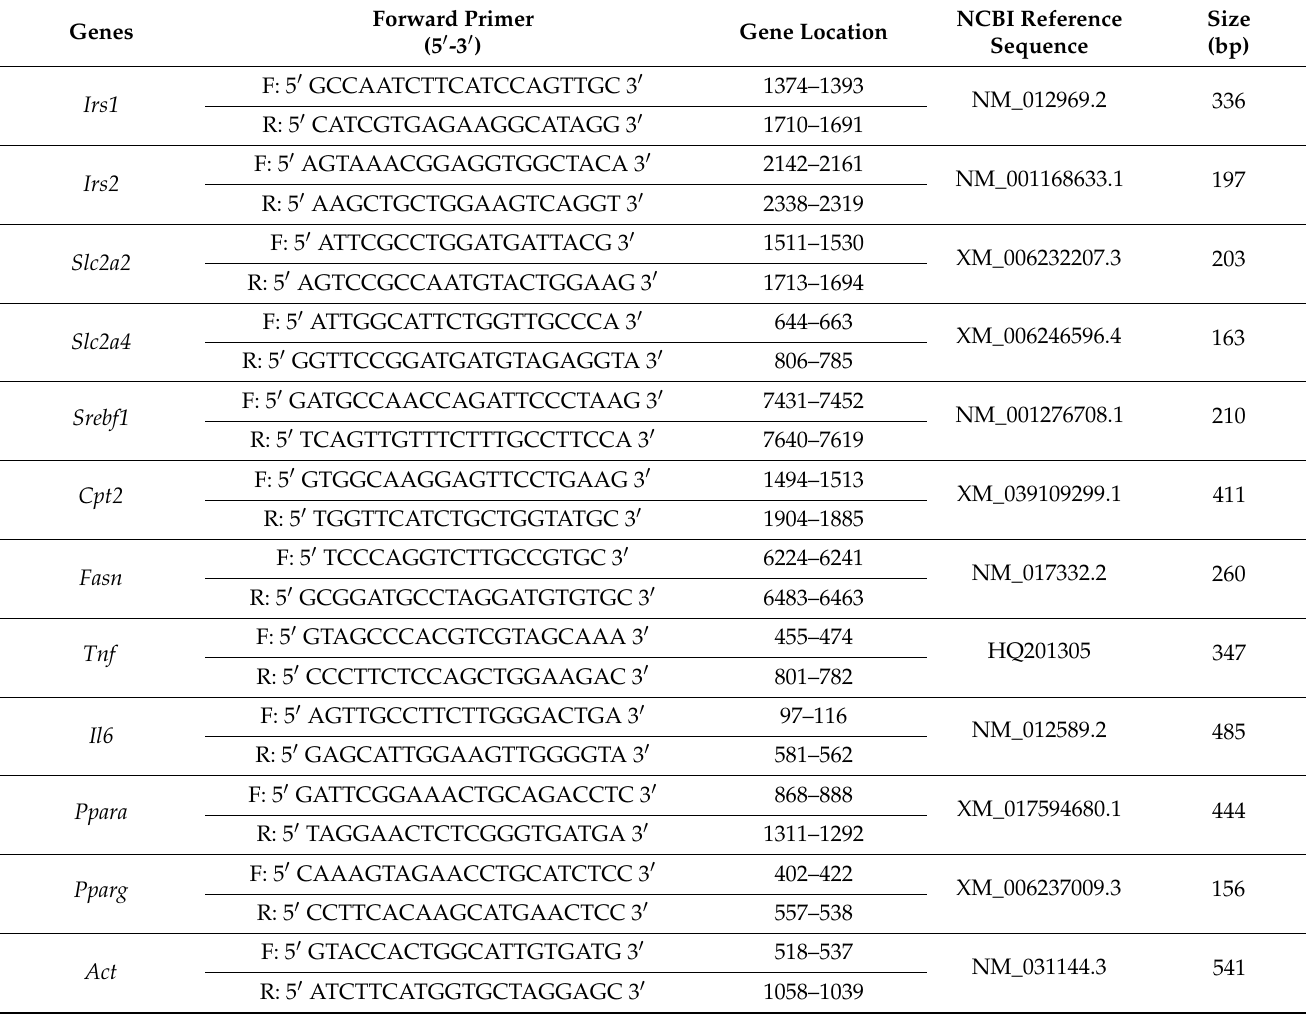
Table 1. List of primers for real-time PCR